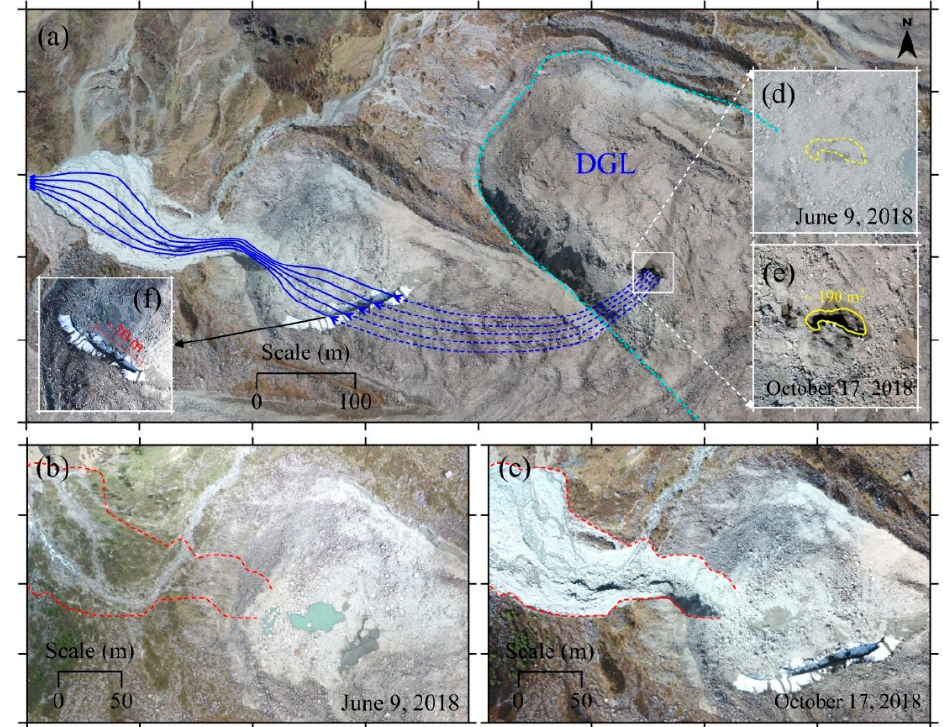
Figure 12. ( a ) The drainage path of the glacial lake outburst flood in July 2018 for the DGL, with the dashed blue lines being the conjectured subglacial channel, the solid blue lines being drawn based on flood scour traces, and the cyan dotted line showing the outline of the DGL. ( b , c ) are orthophotos based on images acquired by drones on June 9 and October 17, 2018, respectively, with the red dotted line showing the flood-damaged surface area. ( d , e ) are orthophotos of the new, large drainage entrance at the bottom of the DGL basin on 9 June and 17 October 2018, respectively, with the yellow line showing the outline of this drainage entrance. ( f ) shows the outlet of the DGL outburst flood.